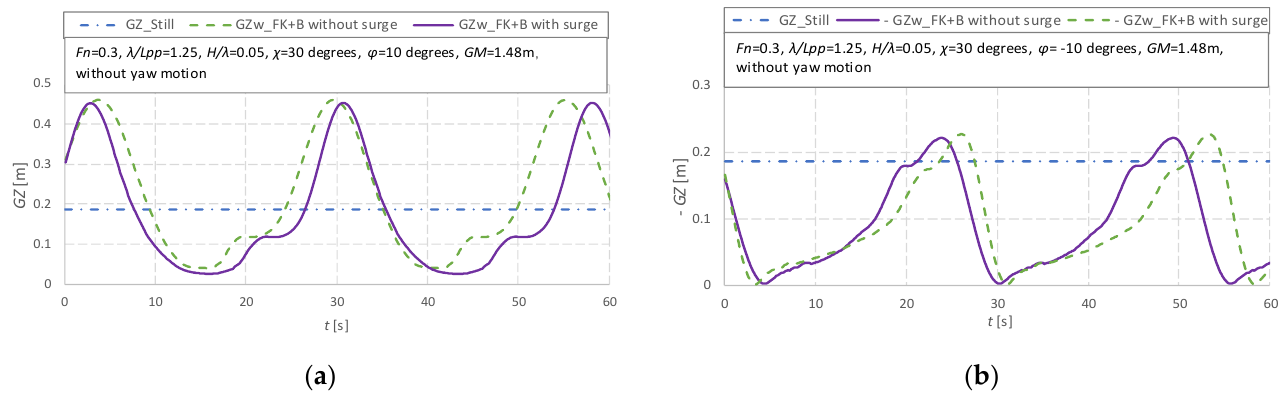
Figure 4. The roll-restoring arms with and without the surge motions, with ϕ = 10, − 10 degrees, ( a ) starboard; ( b ) port.